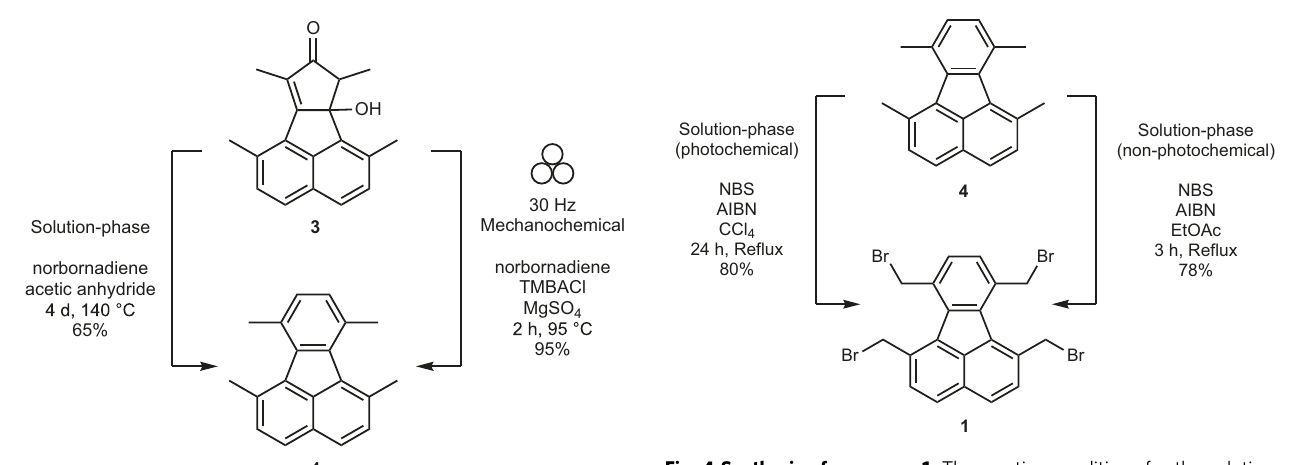
Fig. 4 Synthesis of precursor 1. The reaction conditions for the solution- phase photochemical synthesis is adopted from Borchardt et al.